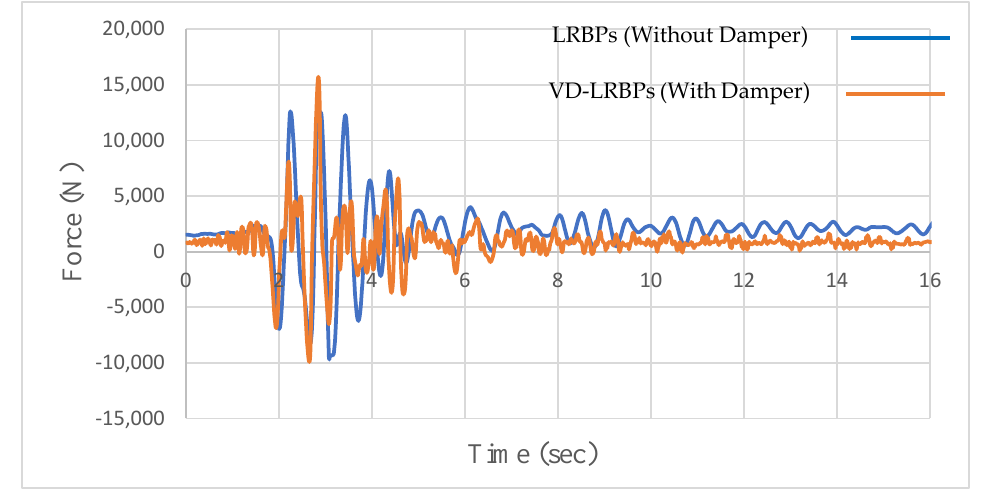
Figure 19. Force histories that pier 1 experiences under the Northridge earthquake.